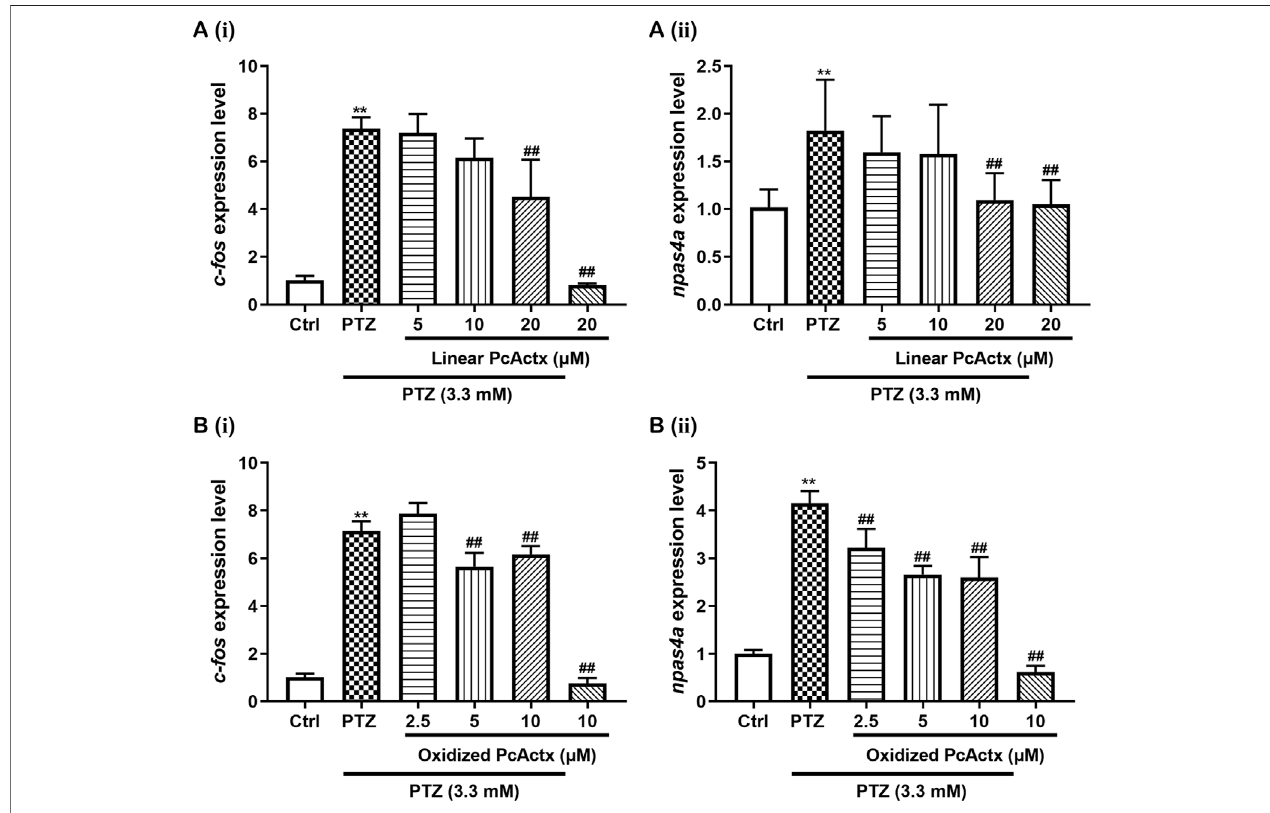
FIGURE 8 | PcActx peptides prevented IER gene expression in PTZ-induced seizures of zebra fi sh. (A) Linear PcActx peptide. (B) . Oxidized PcActx peptide. ( ⅰ ). c-fos expression level. ( ⅱ ). npas4a expression level. Data are expressed as means ± SD ( n (cid:2) 4 – 6). * p < 0.05 vs Ctrl group, ** p < 0.01 vs Ctrl group, # p < 0.05 vs PTZ group, ## p < 0.01 vs PTZ